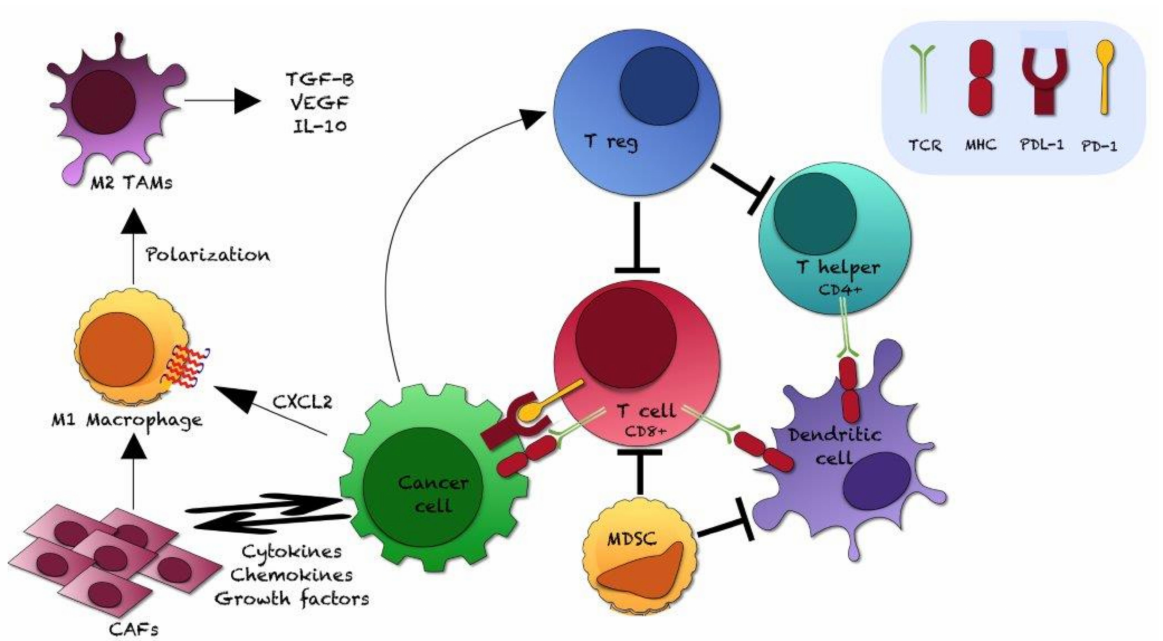
Figure 4. Interaction of prostate cancer cells with other cell types of the tumor microenvironment. CAFs: cancer-asssociated fibroblasts; CXCL2: Chemokine (C-X-C motif) ligand 2; IL-10: Interleukin-10; MDSC: myeloid-derived suppressor cell; MHC: major histocompatibility complex; TAMs: tumor-associated macrophages; T cell CD8+: CD8+ Cytotoxic T lymphocyte; TCR: T cell receptor; TGF- β : Tumor Growth Factor β ; T helper CD4+: CD4+ helper T lymphocyte; T reg: regulatory T cell; VEGF: Vascular-Endothelial Growth Factor; PD-1: programmed death 1; PDL-1: programmed death ligand